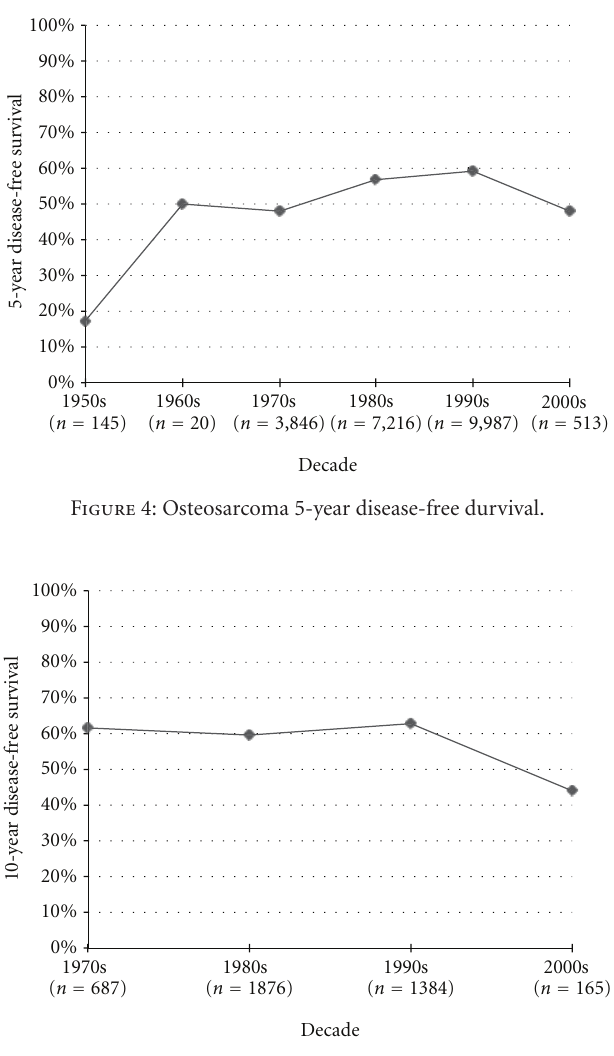
Figure 5: Osteosarcoma 10-year disease-free survival.